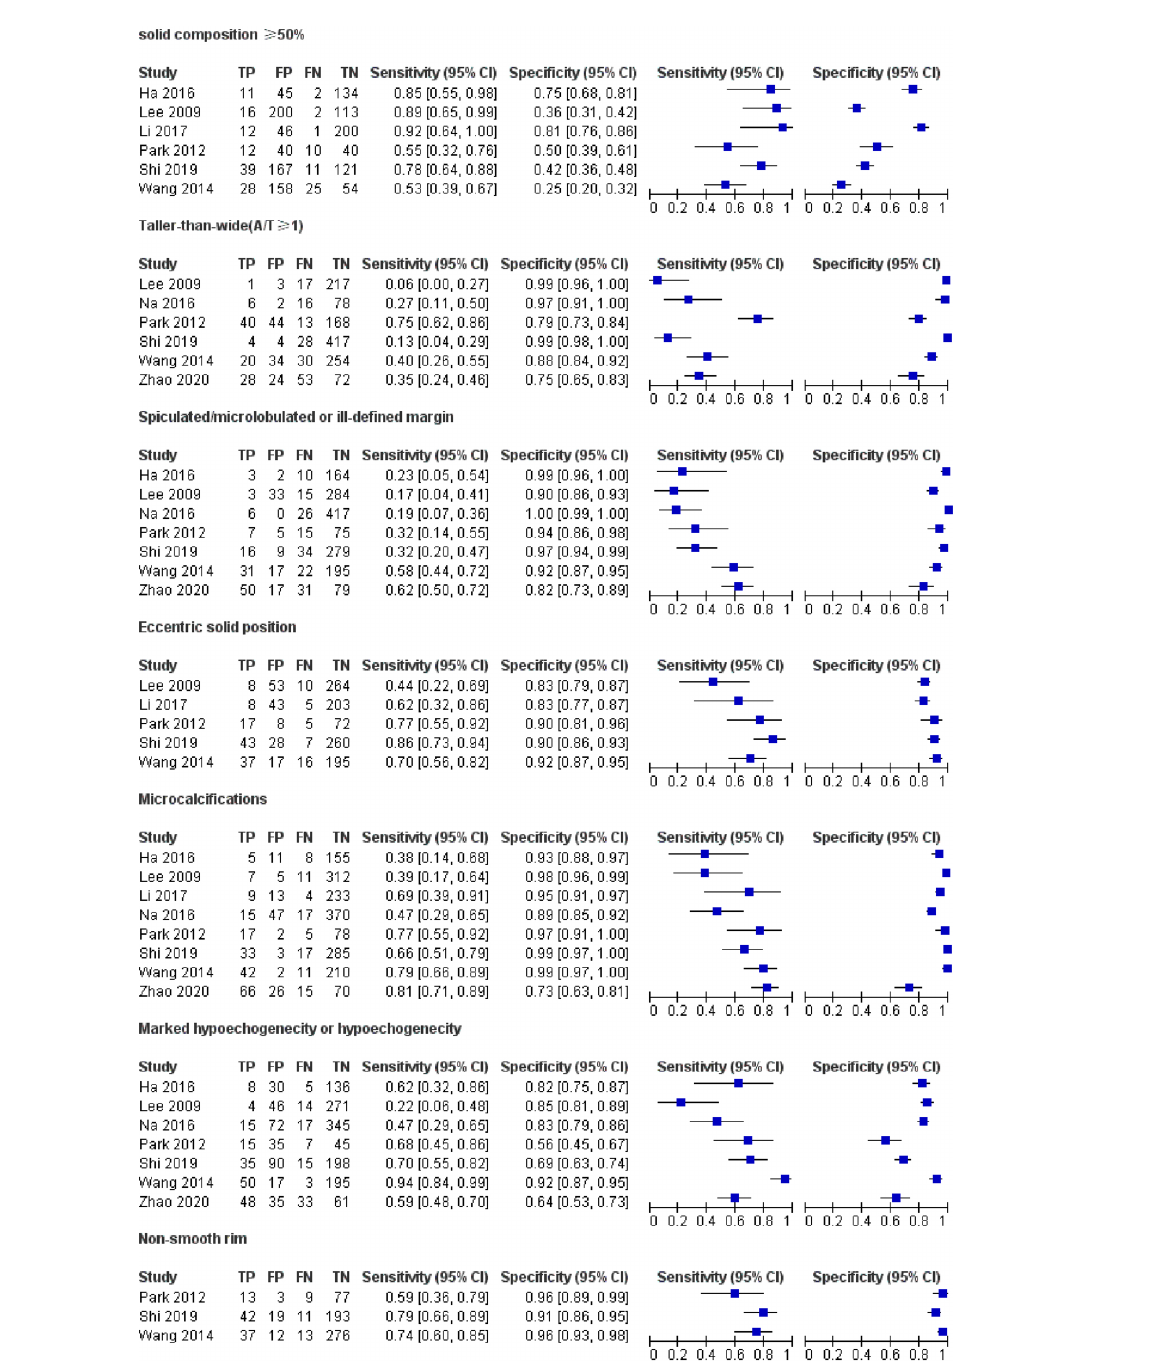
FIGURE 4 | Forest plots of pooled sensitivity and speci fi city of US. Univariate analyses were performed for sensitivity and speci fi city, respectively. Except nodules with a solid portion ≥ 50%, the other six features revealed good speci fi city through a qualitative